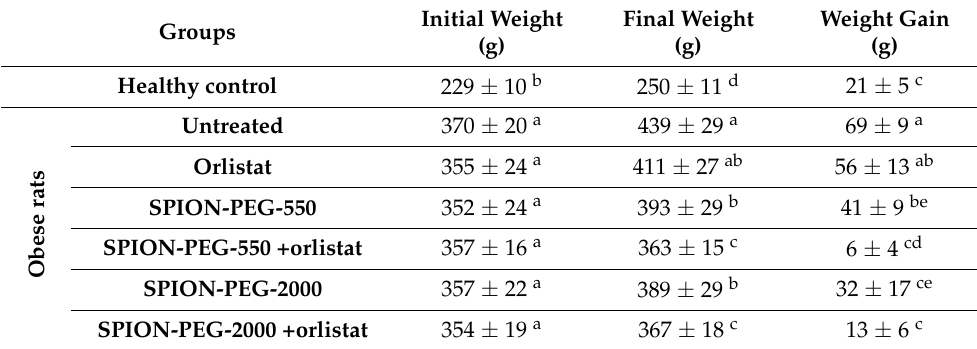
Table 2. Statistical analysis of initial and final body weights and weight gain in the different stud- ied groups.